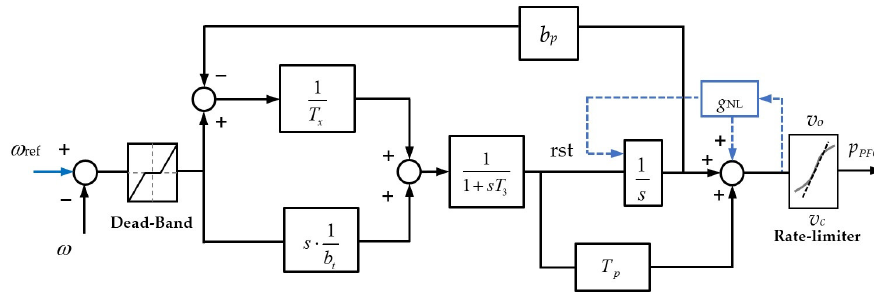
Figure 3. Control scheme of the detail model of the Hydro primary frequency regulation.